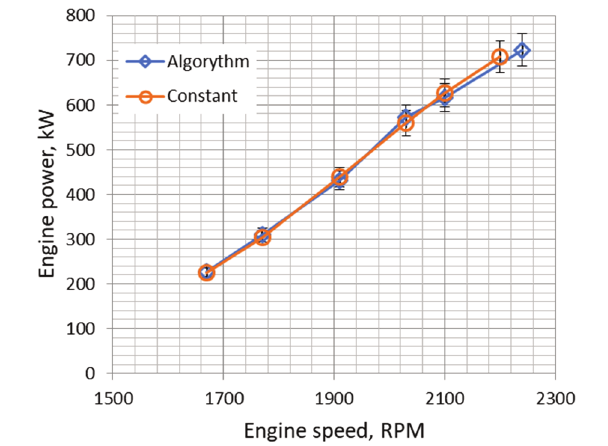
Fig. 3. Relationship between power and rotational speed for constant and variable ignition advance angle